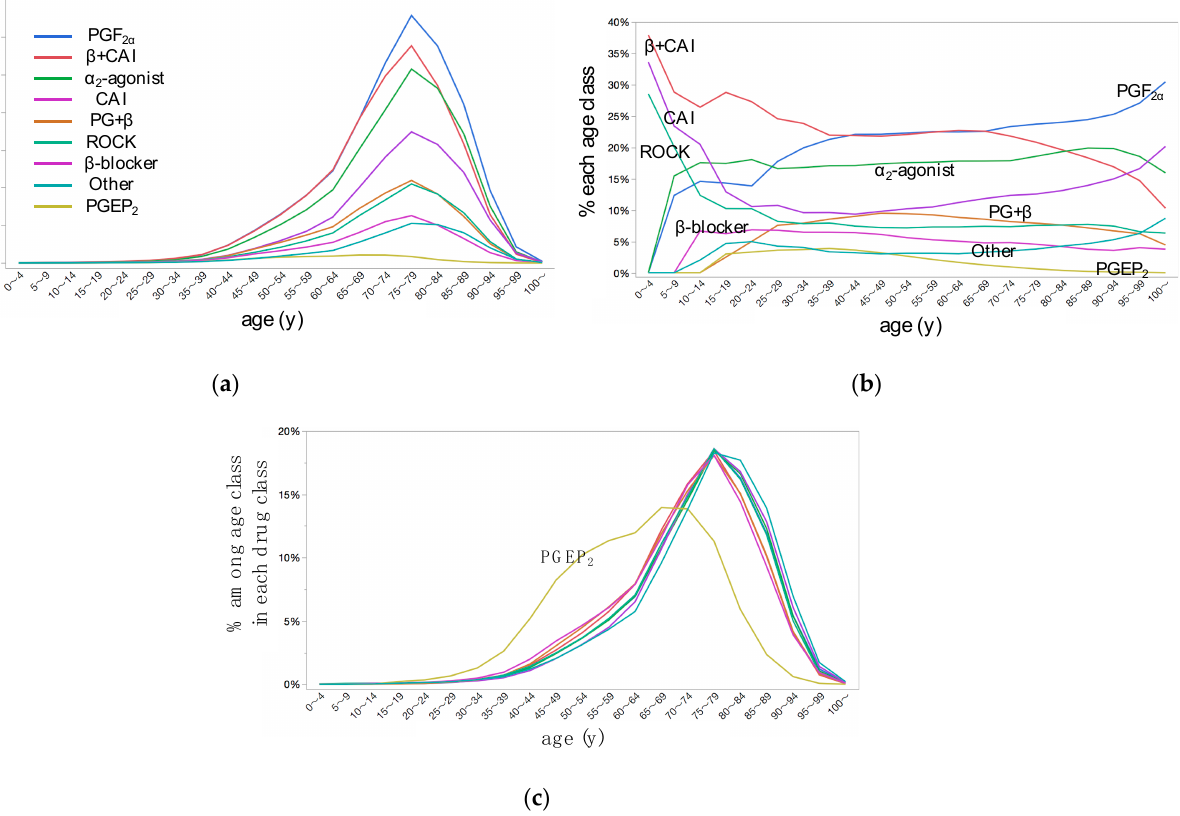
Figure 5. Age-dependent distributions of prescription dose of topical anti-glaucoma medications stratified by medication class. ( a ) Actual prescription dose. ( b ) Percentage of prescription dose in each age class. ( c ) Percentage of prescription dose in each age class in each medication class. PGF 2 α , prostaglandin F 2 α agonist; CAI, carbonic anhydrase inhibitor; β + CAI, foxed combination of β -blocker and CAI; PG + β , fixed combination of PGF 2 α and β -blocker; ROCK, rho kinase inhibitor; PGEP 2 , prostaglandin EP 2 agonist.